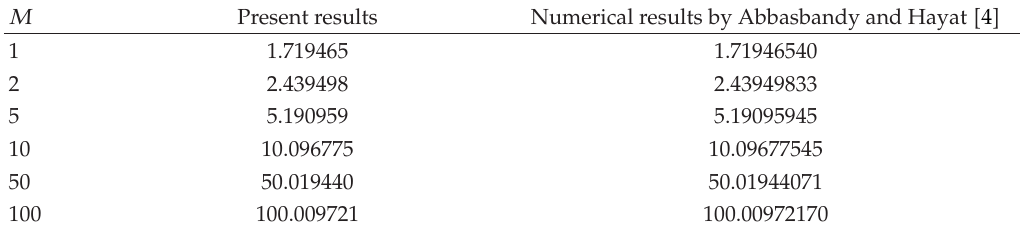
Table 1: (cid:2) 10 , 10 (cid:3) homotopy-Pade approximation at m (cid:8) 2 , λ (cid:8) 0 , γ (cid:8) 0.